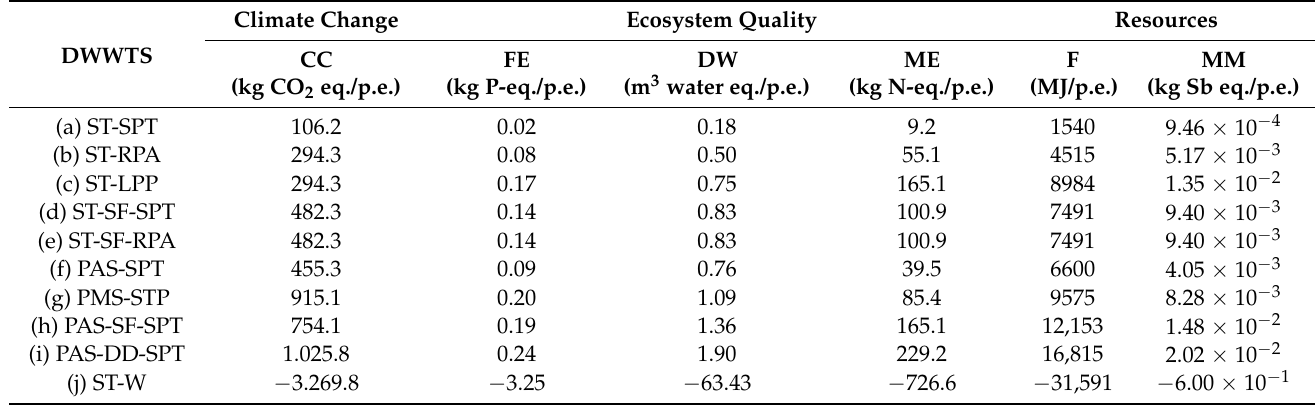
Table A5. Operational environmental burdens per population equivalent (p.e.) for each DWTTS during its 30-year life cycle. Climate Change Ecosystem Quality DWWTS